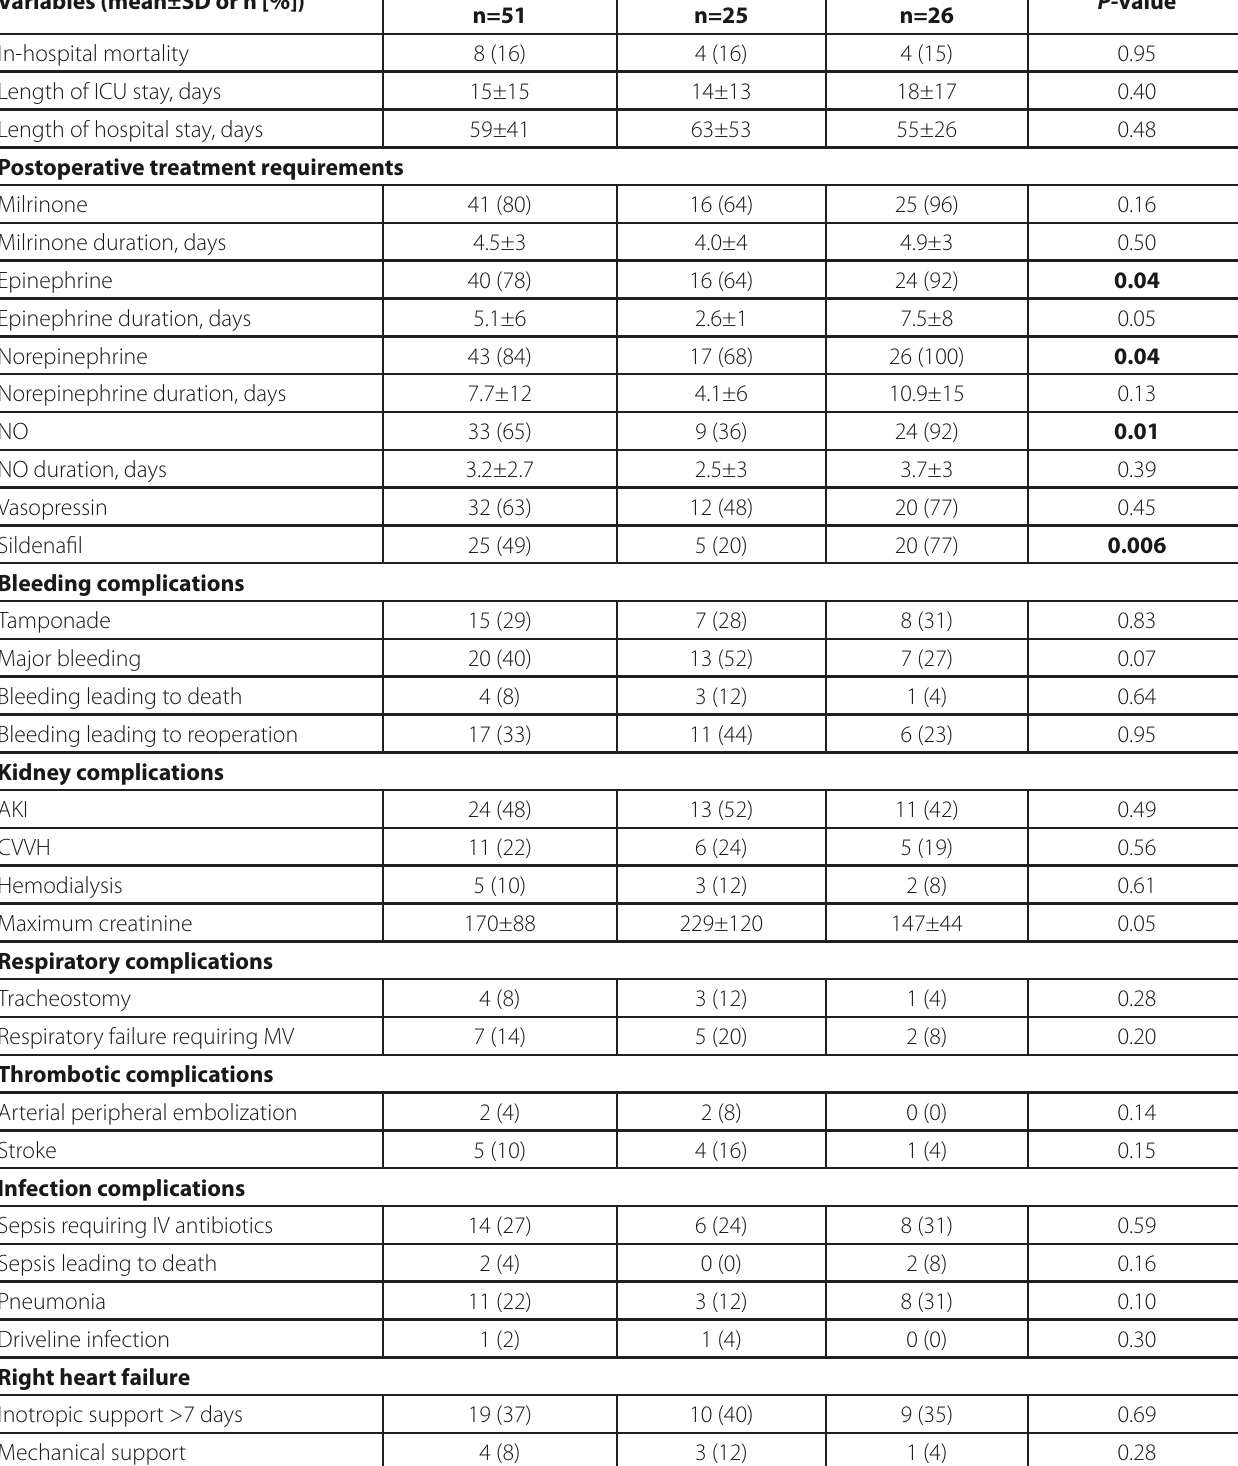
Table 1. Postoperative in-hospital outcomes and complications following HeartMate II implantation by treatment era. Variables (mean±SD or n